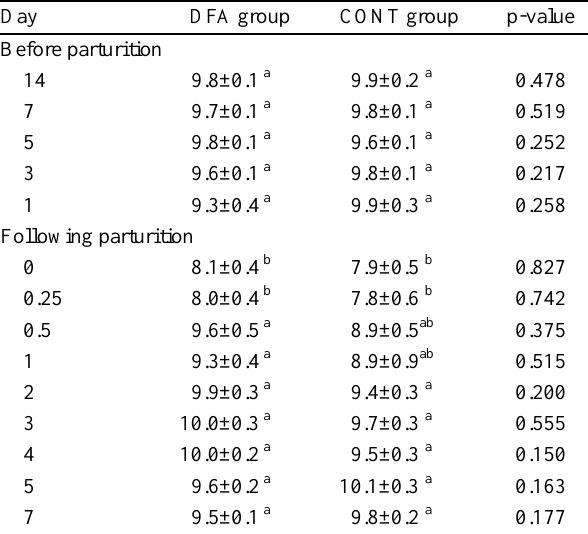
Table 2. Changes in serum calcium concentration before and